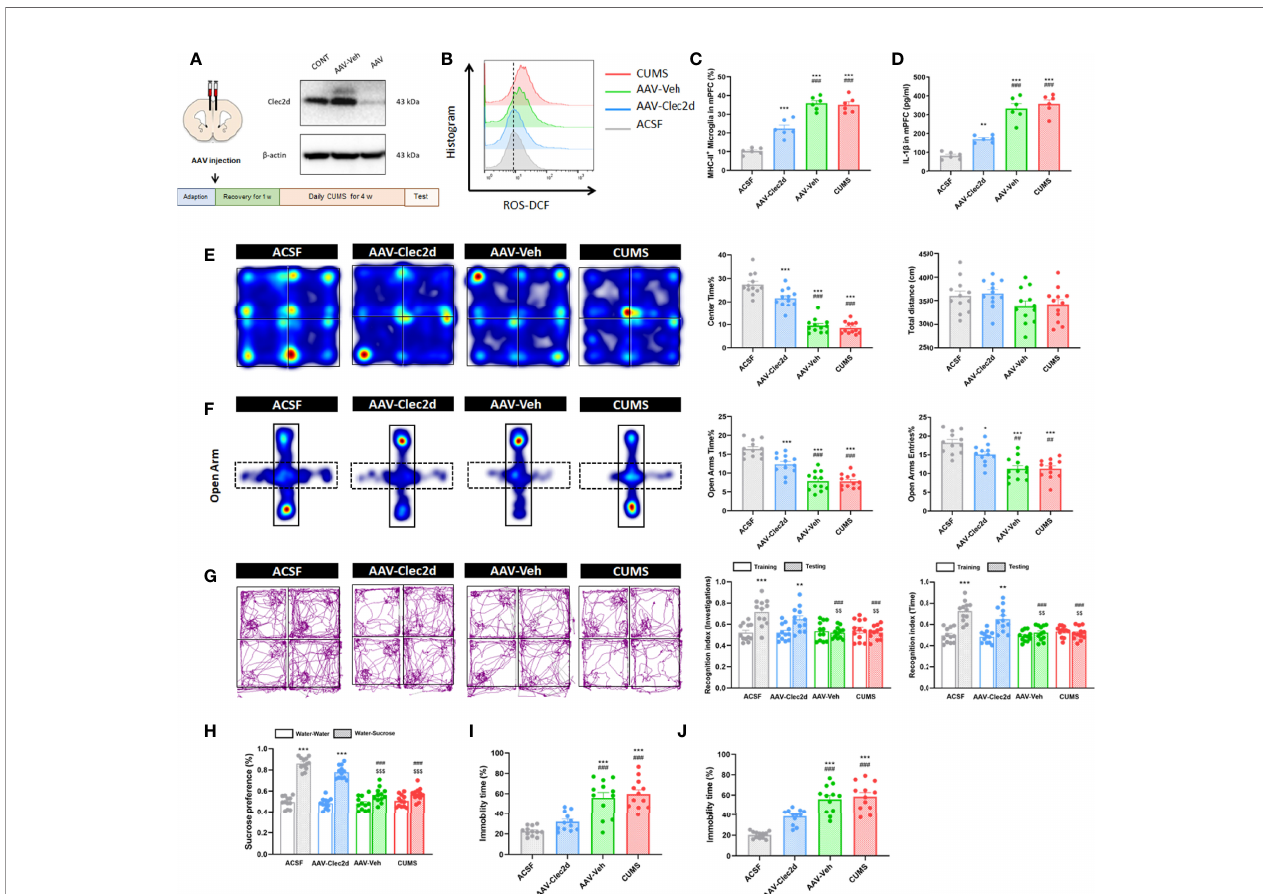
FIGURE 8 | Clec2d knocking-down reduced microglial activation and in fl ammation in mPFC and improved negative emotional behaviors in mice with CUMS. (A) Experimental protocol for mice receiving CUMS with Clec2d knocking-down in mPFC and representative Western blots showing the molecular expression